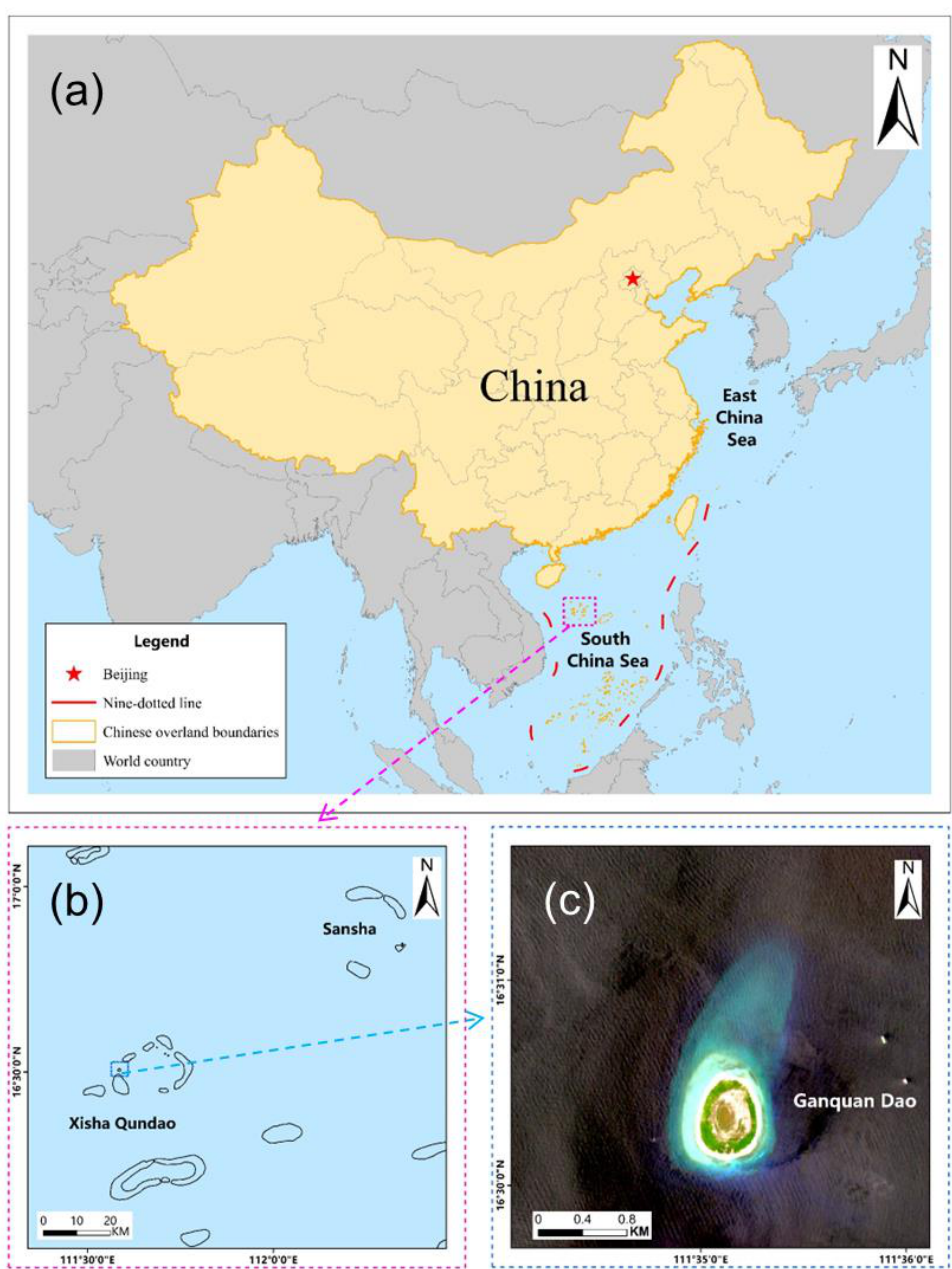
Figure 1. ( a ) Location of the area shown in ( b ); ( b ) location of Xisha Qundao, blue rectangle represents the location of Ganquan Dao; and ( c ) true color image derived from a Sentinel-2 image of Ganquan Dao.